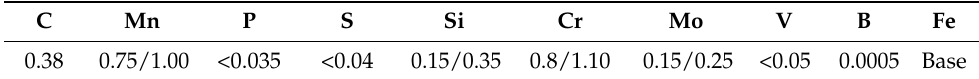
Table 1. Chemical composition of AISI 4140 steel (wt%).